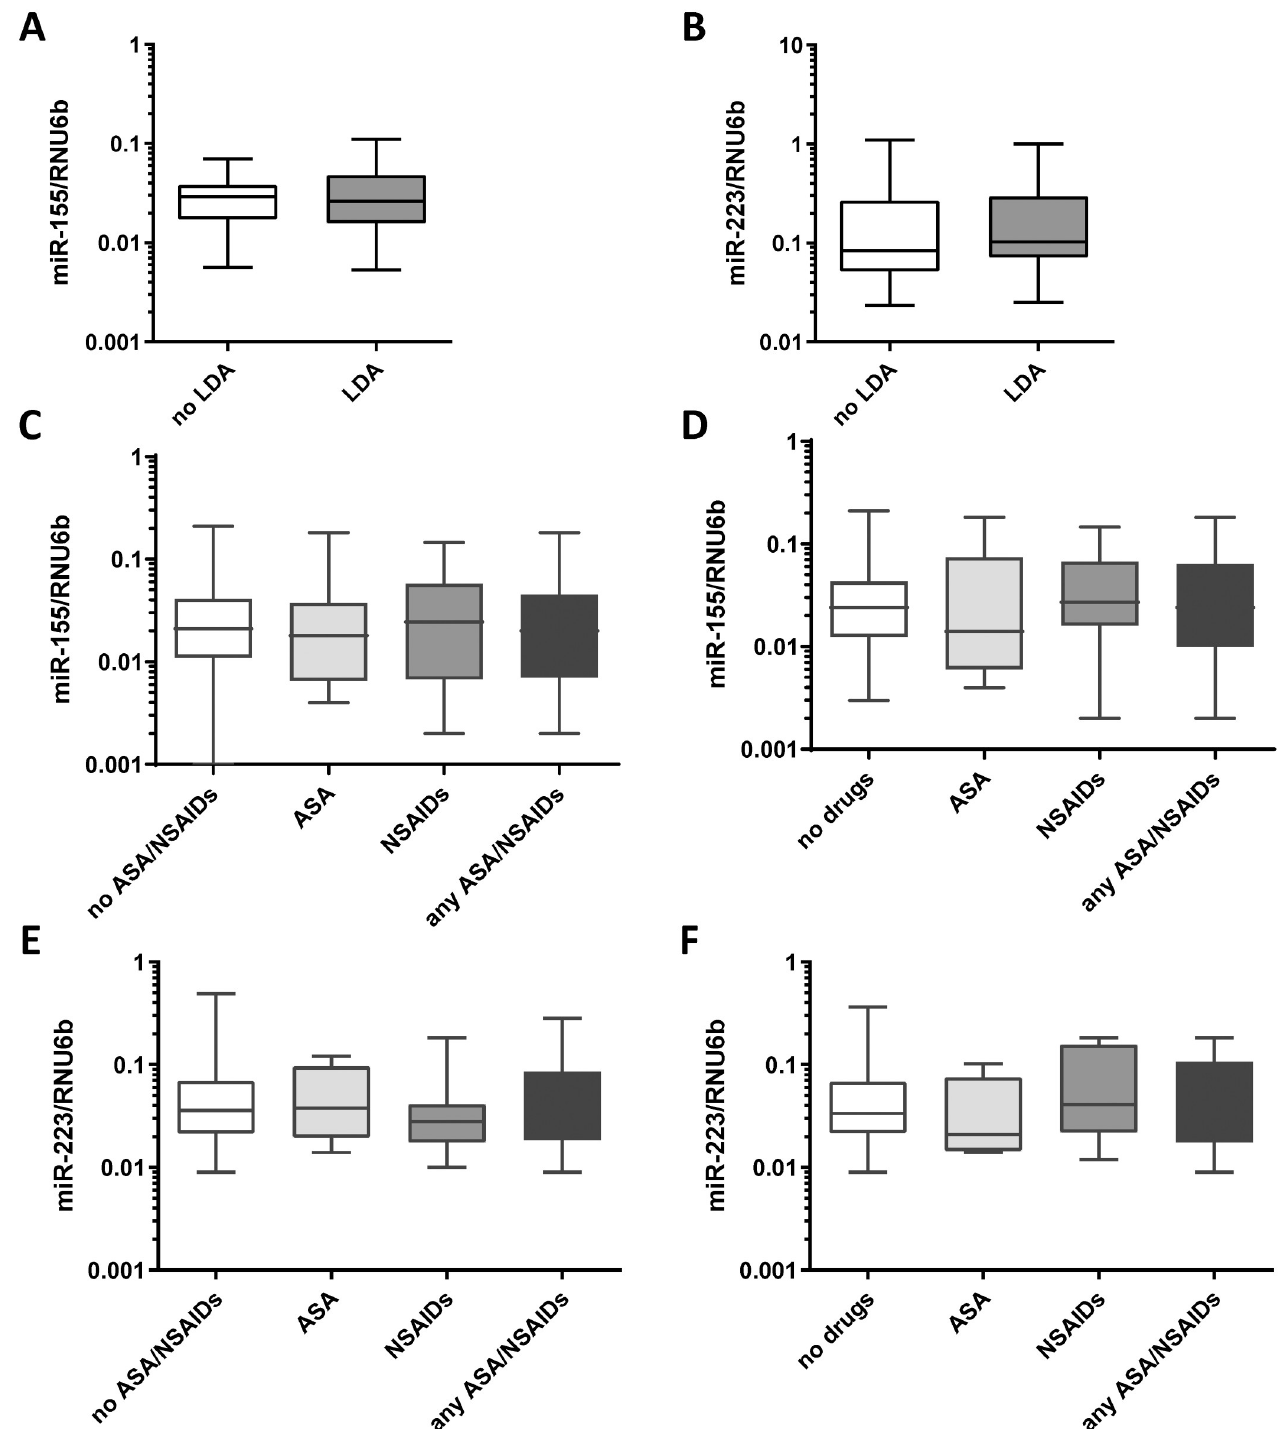
Fig 2. Effect of LDA, ASA or NSAIDs on miR-155 and miR-223 expression. (A) MiR-155 and (B) miR-223 expression levels in gastric antrum biopsies from healthy subjects of the LDA-study (n = 29) before and after 7 days of daily intake of LDA (100mg). (C) Expression of miR-155 in gastric antrum biopsies from patients with no ASA/NSAIDs (n = 113), with ASA (n = 25), NSAIDs (n = 34) or either of drugs (n = 70). (D) Expression of miR-155 in mucosa in patients with no PPI intake: no drugs (n = 65), ASA (n = 12), NSAIDs (n = 22) or ASA/NSAIDs (n = 36). (E) Expression of miR-223 in gastric antrum biopsies from patients with no ASA/NSAIDs (n = 57), with ASA (n = 13), NSAIDs (n = 17) or either of drugs (n = 36). (F) Expression of miR-223 in mucosa in patients with no PPI intake: no drugs (n = 34), ASA (n = 5), NSAIDs (n = 8) or ASA/NSAIDs (n = 17). MiRNA expression levels are shown as 2 Δ CT -values normalized to RNU6b and data are shown as box-plots where the horizontal line marks the median value.